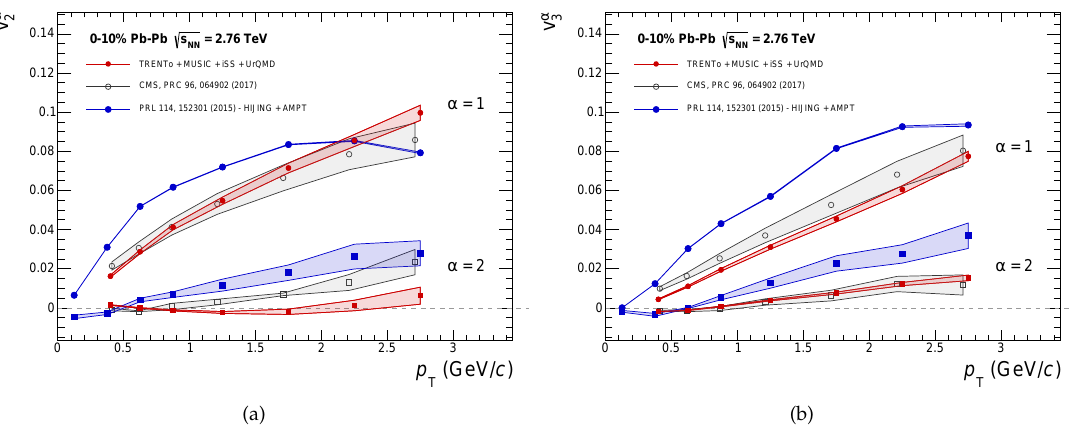
Figure 2. Principal components of the two-particle correlation matrix for Pb-Pb collisions at center of √ s NN = 2.76 TeV and 0% to 10% centrality for n = 2 (2(a)) and for n = 3 (2(b)). Results mass energy from this work (red) are compared to the original PCA work [8] (blue) and to data from the CMS Collaboration [13]